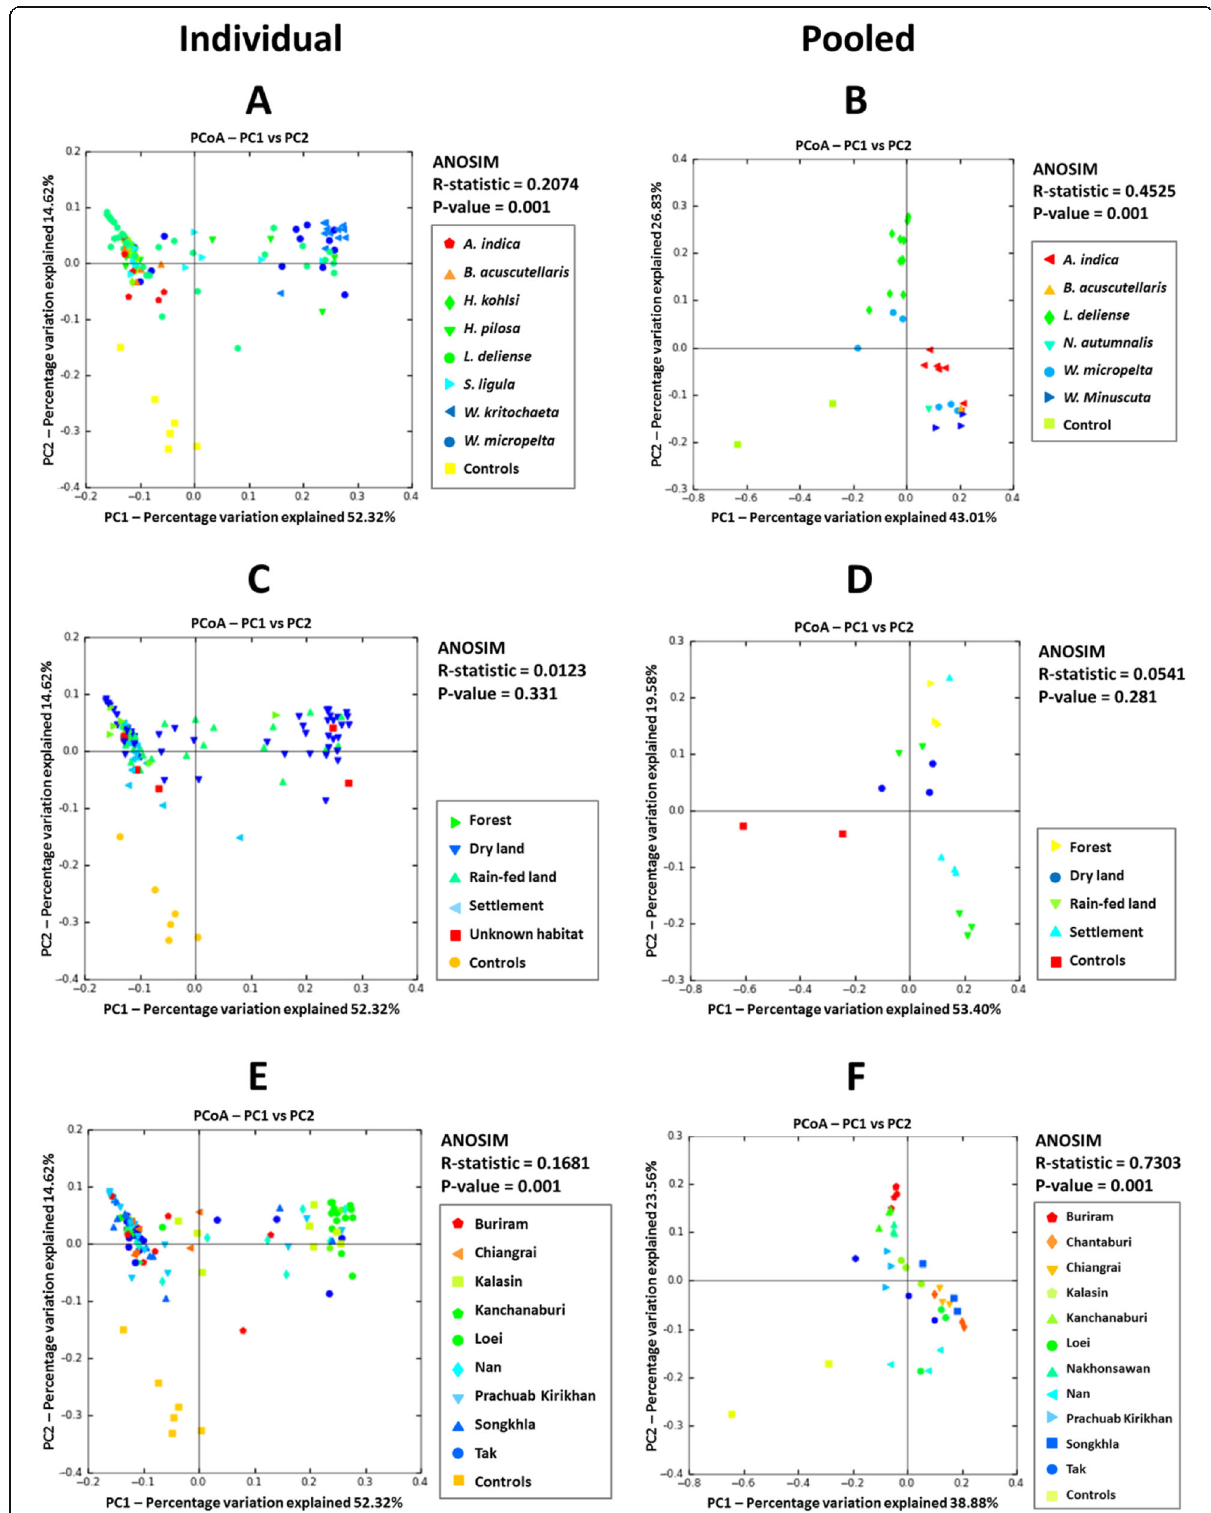
Fig. 7 Principal coordinates analysis plots created using the unweighted UniFrac metric showing bacterial community clustering of individual (left panels) and pooled chiggers (right panels) among different sample categories. a , b chigger species; c , d habitat; and e , f study site. Control data are shown for reference only and were not included in the